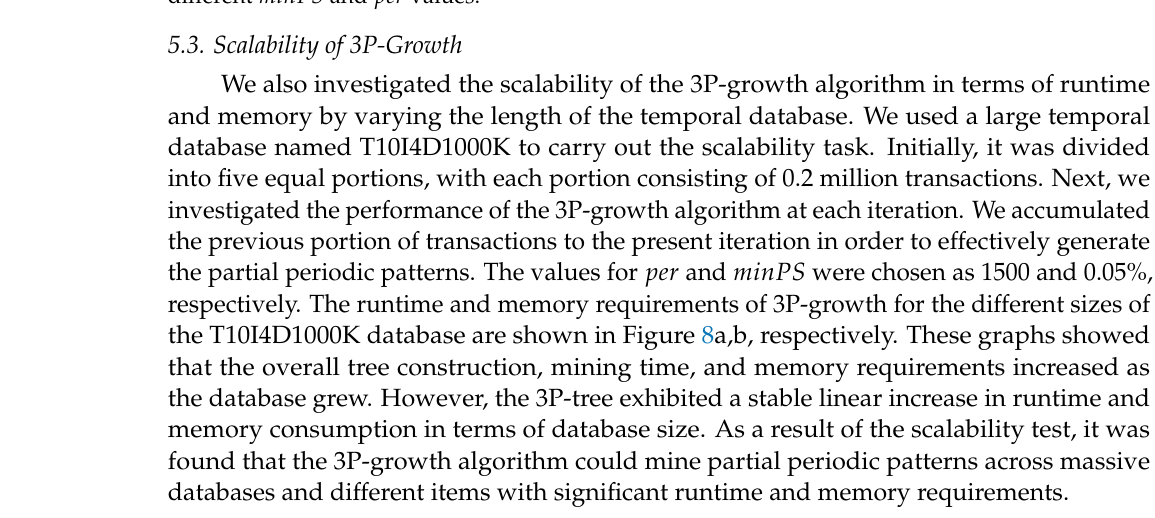
Figure 7. Memory consumption details of the 3P-growth algorithm in the various databases ( a – d ) for different minPS and per values.